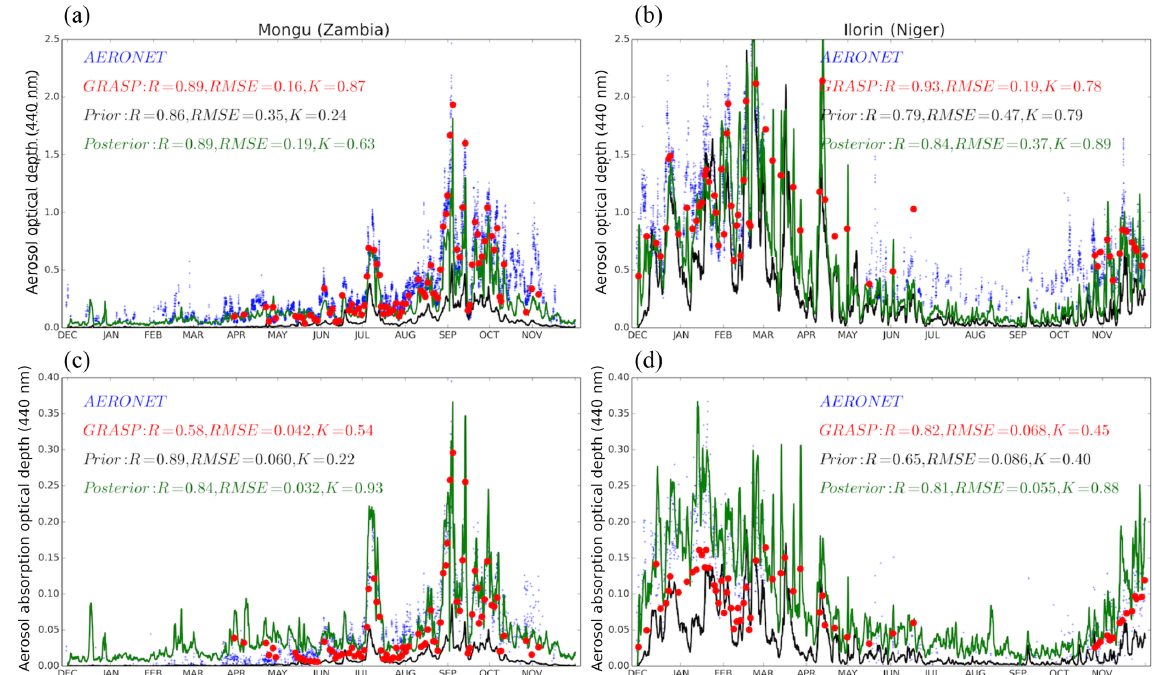
Figure 19. Time serial AOD (a, b) and AAOD (c, d) from AERONET (blue crosses), PARASOL/GRASP (red circles), prior GEOS-Chem (black line) and posterior (green line) GEOS-Chem simulations at two sites (Mongu and Ilorin). The error statistics parameters between PARASOL/GRASP and prior and posterior GEOS-Chem simulations with AERONET are also shown in the